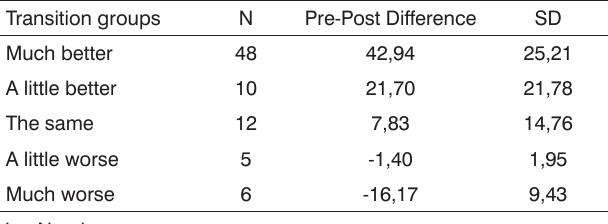
Table 6. Difference in the pre and post scores per transition